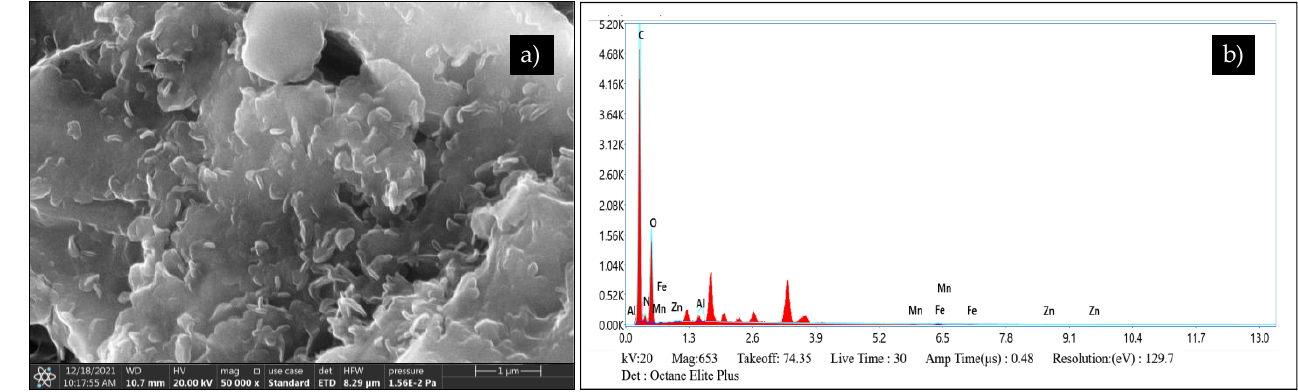
Figure 2. ( a ) Scanning electron microscopy (SEM-Zeiss) image and ( b ) energy-dispersive X-ray spec- troscopy (EDS) spectrum of biochar derived from pyrolysis of the spent mushroom substrate